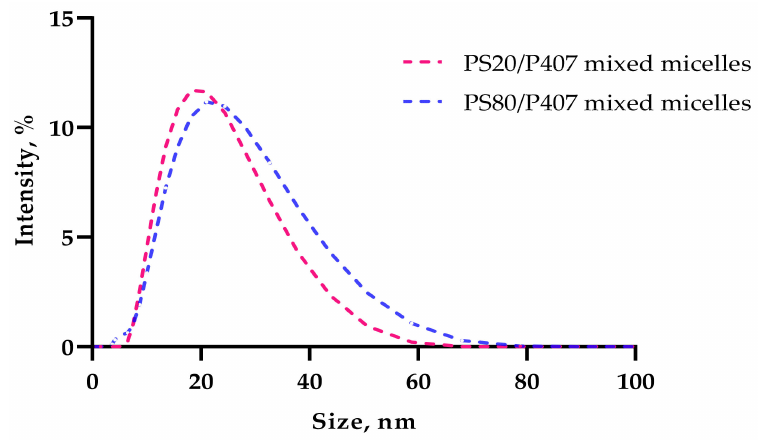
Figure 3. Size distribution (by intensity) of clozapine-encapsulated binary PS20/P407 and PS80/P407 mixed micelles ( n = 3).